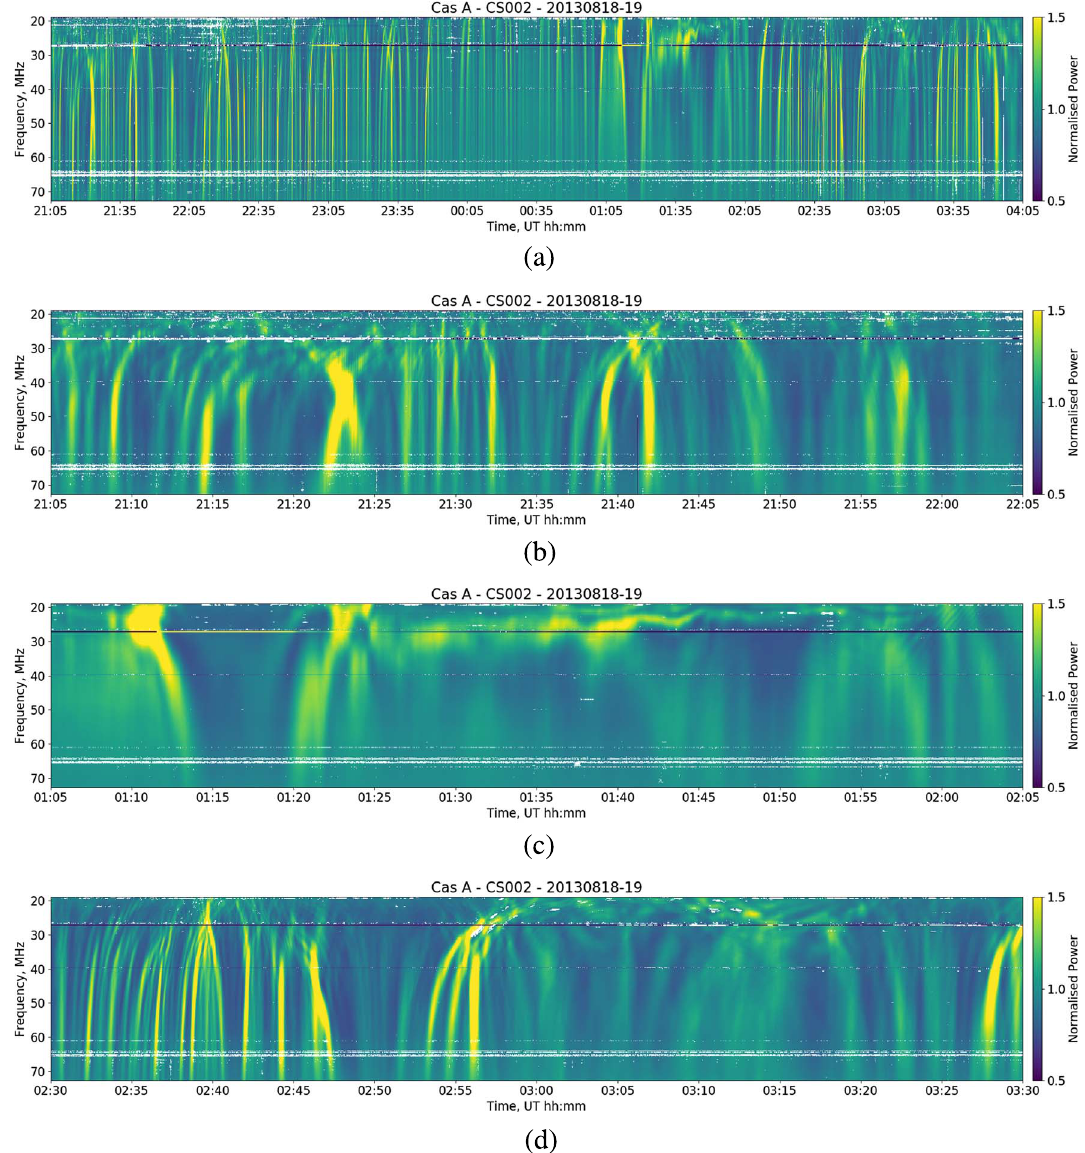
Fig. 2. Dynamic spectra of normalised intensity data taken by LOFAR station CS002 during the observation of Cas A on 18 – 19 August 2013. The dynamic spectrum of the entire observing period is given at the top, with zooms into three different hours of observation below to illustrate the range of conditions seen. White areas within the plots indicate where RFI was identi fi